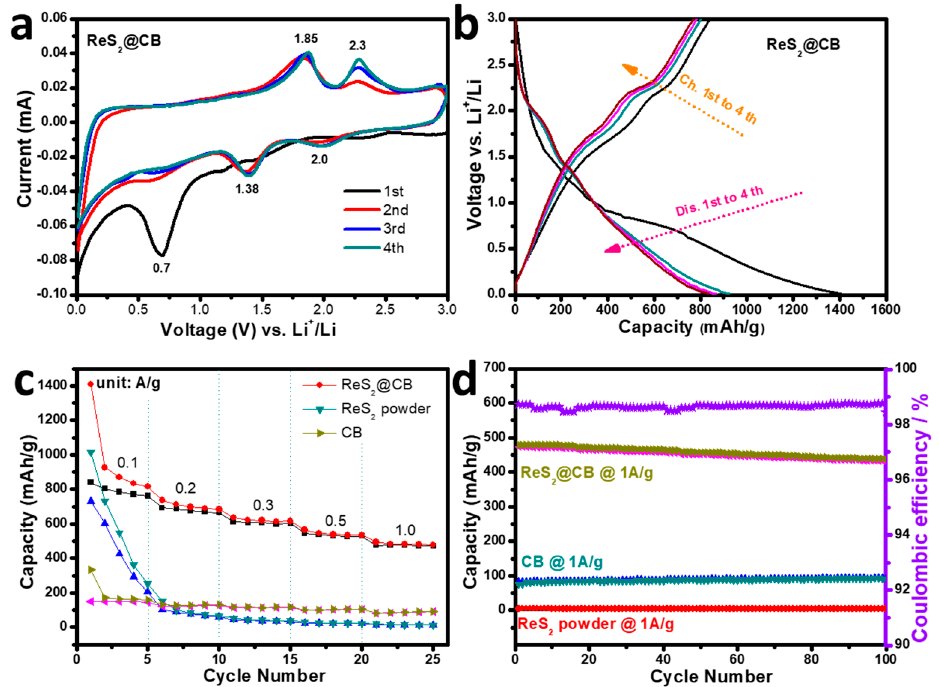
Figure 5. ( a ) CV curve of the ReS 2 @CB, ( b ) galvanostatic charge/discharge (GCD) process of the ReS 2 @CB in the initial four cycles; ( c ) rate capability of the as-prepared samples at different current densities; and ( d ) cycling performance of each sample at 1 A/g and the corresponding coulombic efficiency of the ReS 2 @CB.